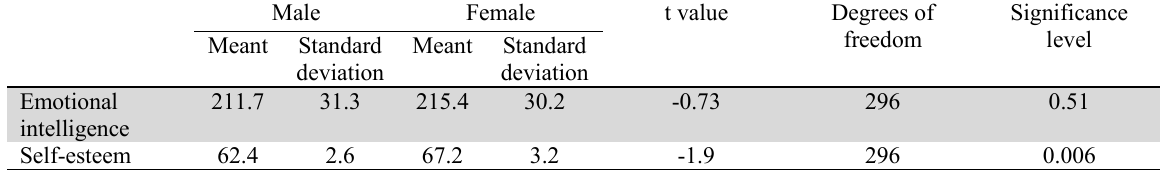
Table 3 indicates there are significant relationships between male and female students in the term of emotional intelligence, self-esteem and academic achievement, which means that self-esteem of female fourth one is confirmed. The results of t test in male and female students in terms of emotional intelligence and